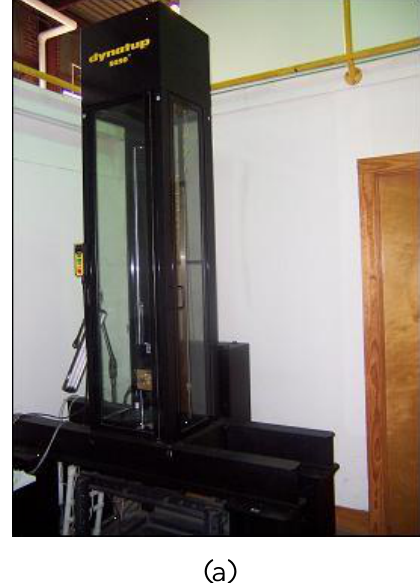
Figure 8. Impact of indenter to a polymeric material (nylon 6,6 and vinyl ester). (a) Impact test instrument, and (b) dimension of